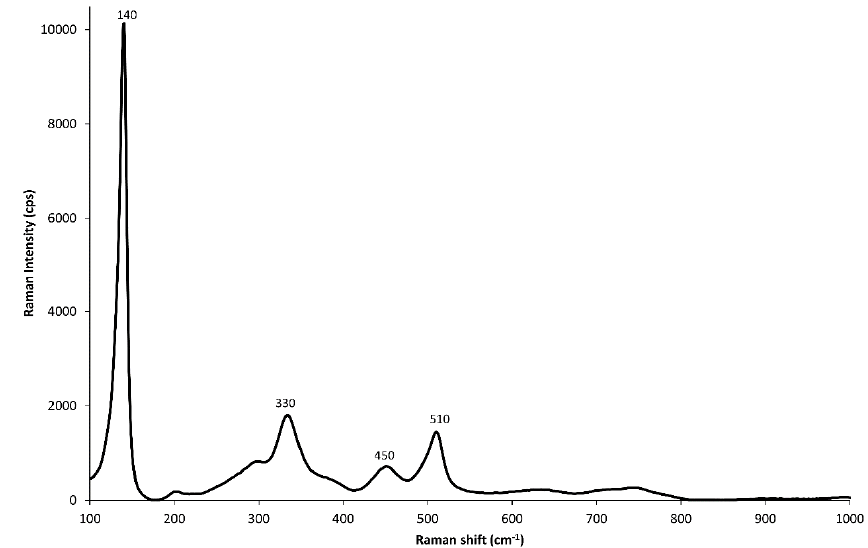
Figure 10. Raman spectrum, in the region from 100 to 1000 cm −1 , of opacifier identified in tessera PN GSO2: note the presence of measured wavenumbers at 140 , 330, 450, 510 typical of Pb-antimonate doped with tin (most intense signal in bold; reference spectra from [47,54,55]). Similar spectra are identified in TN VG1, PN NC1, PN VS1, PN GSO1 and TN VP1. Four tesserae included in the green macro-group are translucent: an olive-green tessera (TN VOL2) and three translucent dark green tesserae (PN VTR1, PN VTR2 and TN VS1). Olive green is a